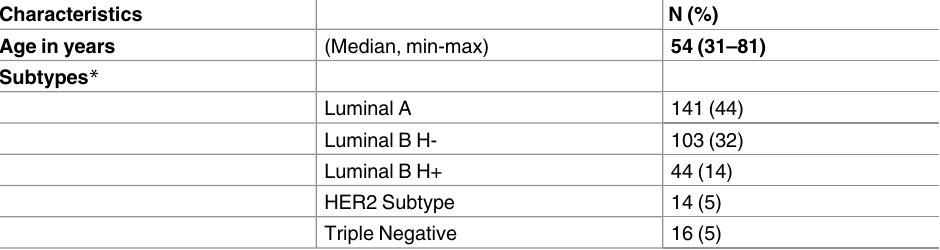
Table 3. Biological findings of 318 patients with positive sentinel lymph-node who underwent axillary dissection (N = 318).